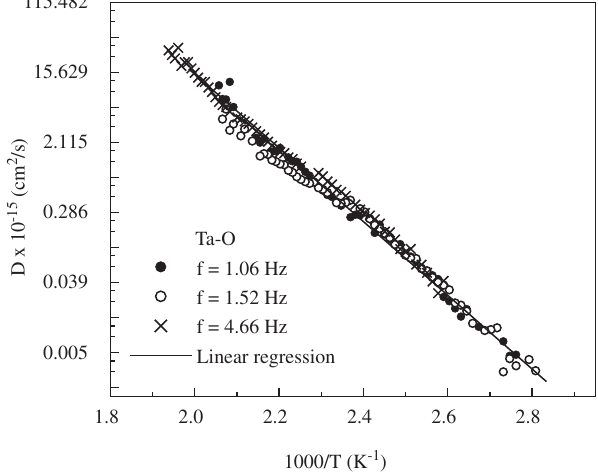
Figure 9. Internal friction as a function of temperature for Ta sample measured with frequency of 1.06 Hz. The full line shows Debye’s peak.